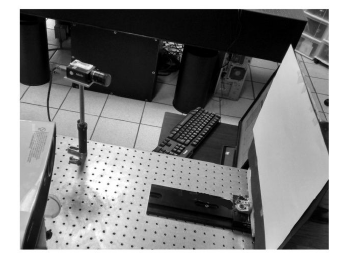
Figure 12. Experimental setup, we used a graduated rail to make the 10 mm